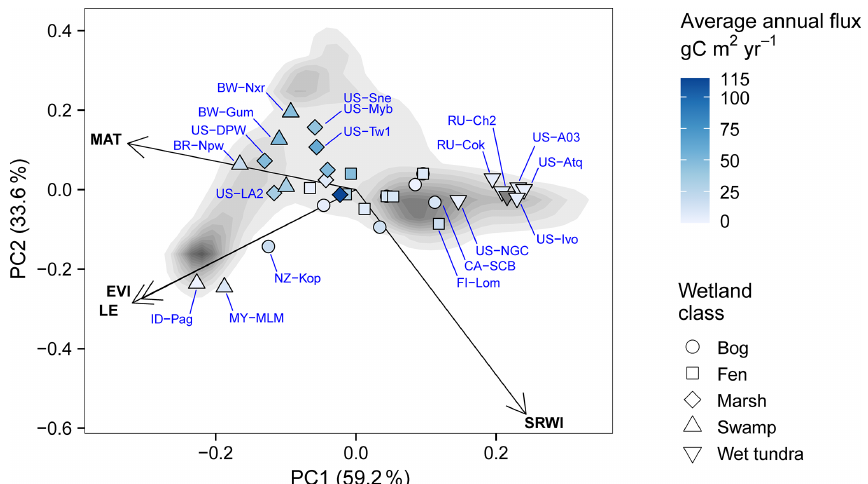
Figure 6. Principal component analysis displaying the distribution of freshwater wetland sites (points) along the two main principal compo- nents together accounting for 91.9% of variance. Tower sites are represented as points with shapes indicating their wetland type and color shade representing the annual methane (CH 4 ) flux (gray points represent sites for which < 6 months of flux data were available to estimate annual budget). Sites codes are labeled in blue text for selected sites deviating from average conditions. Loading variables are represented by the arrows: mean annual temperature (MAT), simple ratio water index (SRWI), latent heat flux (LE), and enhanced vegetation index (EVI). The background shades of gray are a qualitative representation of the density of global wetland pixels and their distribution in the PCA climate space, with darker color representing higher densities (excluding Greenland and Antarctica). Only grid cells with > 5% average wetland fraction according to the WAD2M over 2000–2018 are included (Zhang et al.,